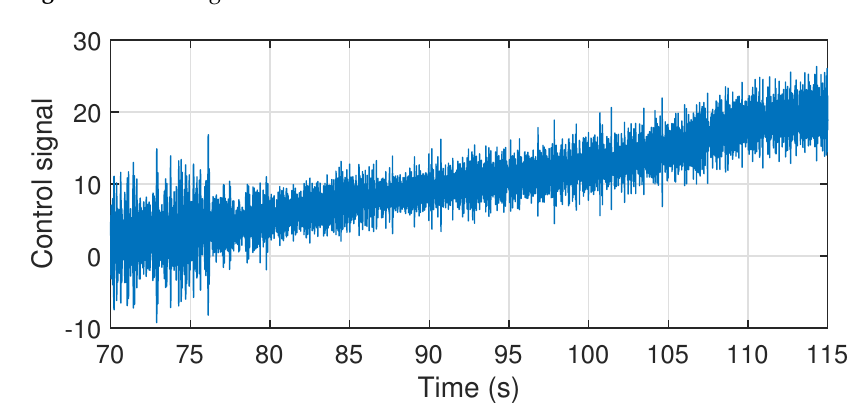
Figure 26. Control signal for pitch axis.